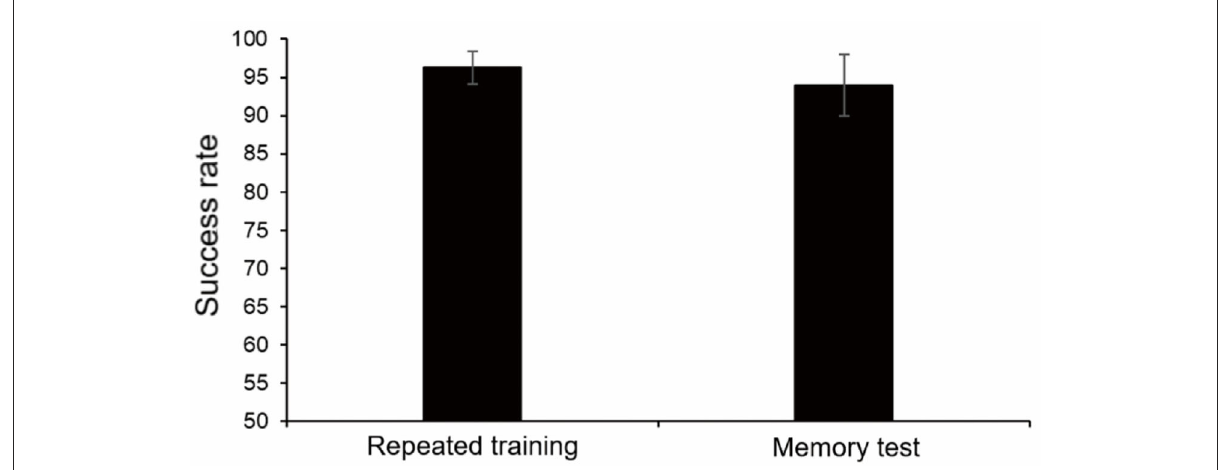
FIGURE7 Results of repeated training and memory test 1 month later. There was no statistically significant difference.